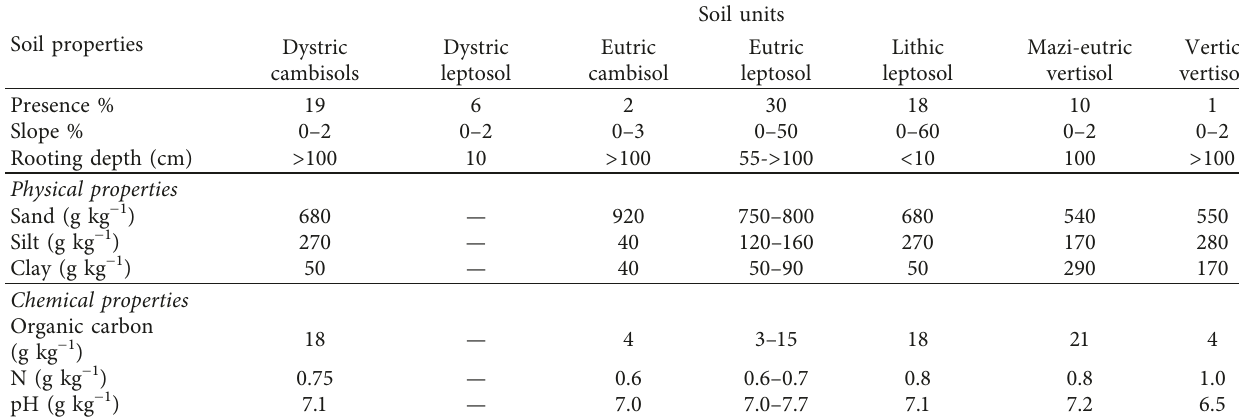
Table 6: Impact of SWC measures on soil properties [35].